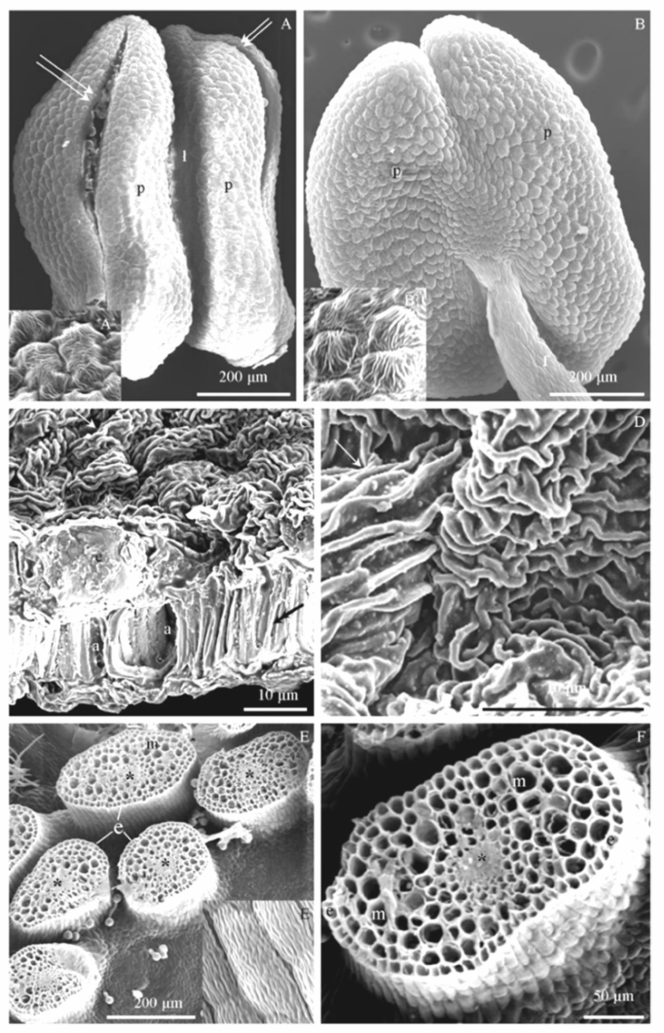
Figure 4. ( A – F ). Micromorphology of the epidermis ( A – D ) and fragments of cross-sections of stamen filaments ( E , F ) at the initial phase of flowering of R. idaeus flowers: ‘Glen Ample’ ( A ), ‘Laszka’ ( B ), ‘Radziejowa’ ( C ), ‘Polka’ ( D ), ‘Pokusa’ ( E ), and ‘Polana’ ( F ): ( A )—surface of the adaxial epidermis of the anther with cracks in the dehiscent anther wall (two arrows), connective (ł) between the anthers (p), cuticle striation on the surface of epidermis cells (Figure 4A), ( B )—striated surface of the abaxial anther epidermis, stamen filament (f), cuticle striation (Figure 4B), ( C , D )—striation of anther epidermis cuticle—undulating multi-directionally arranged striae (arrow), longitudinal cross-section of epidermis cells (e) and endothecium (a) with visible thickening of cell walls (double- headed arrow) (Figure 4C), ( E , F )—cross-section of a filament of stamens arranged in whorls and a striated surface of stamen filaments (Figure 4E), epidermis cells (e), parenchyma cells (m), vascular bundle (asterisk). ( A – F